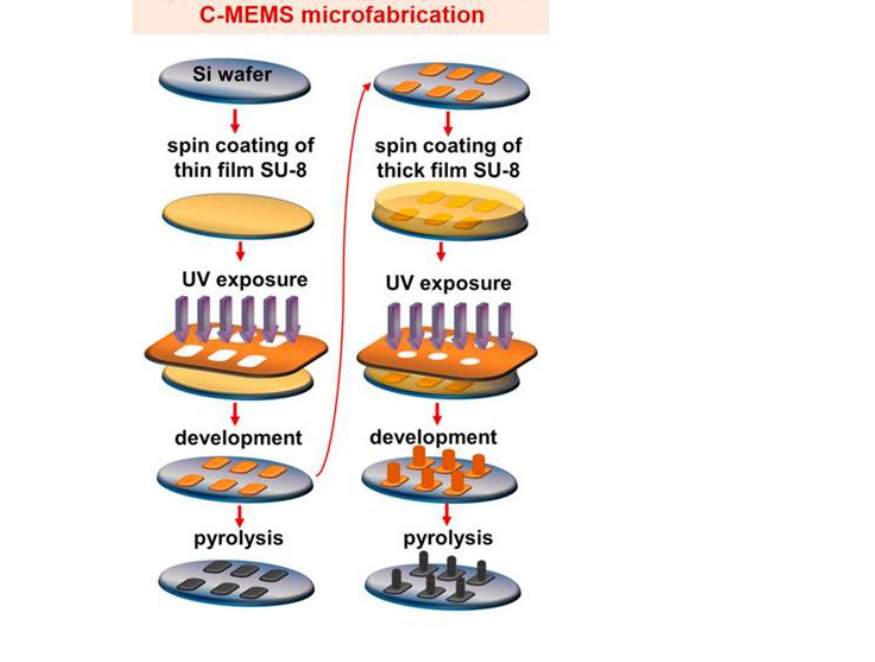
Figure 3. Schematic illustration of a typical photolithography process to fabricate 2D and 3D C-MEMS electrodes. Reprinted with permission from Ref. [118]. Copyright © 2022 Elsevier B.V. All rights